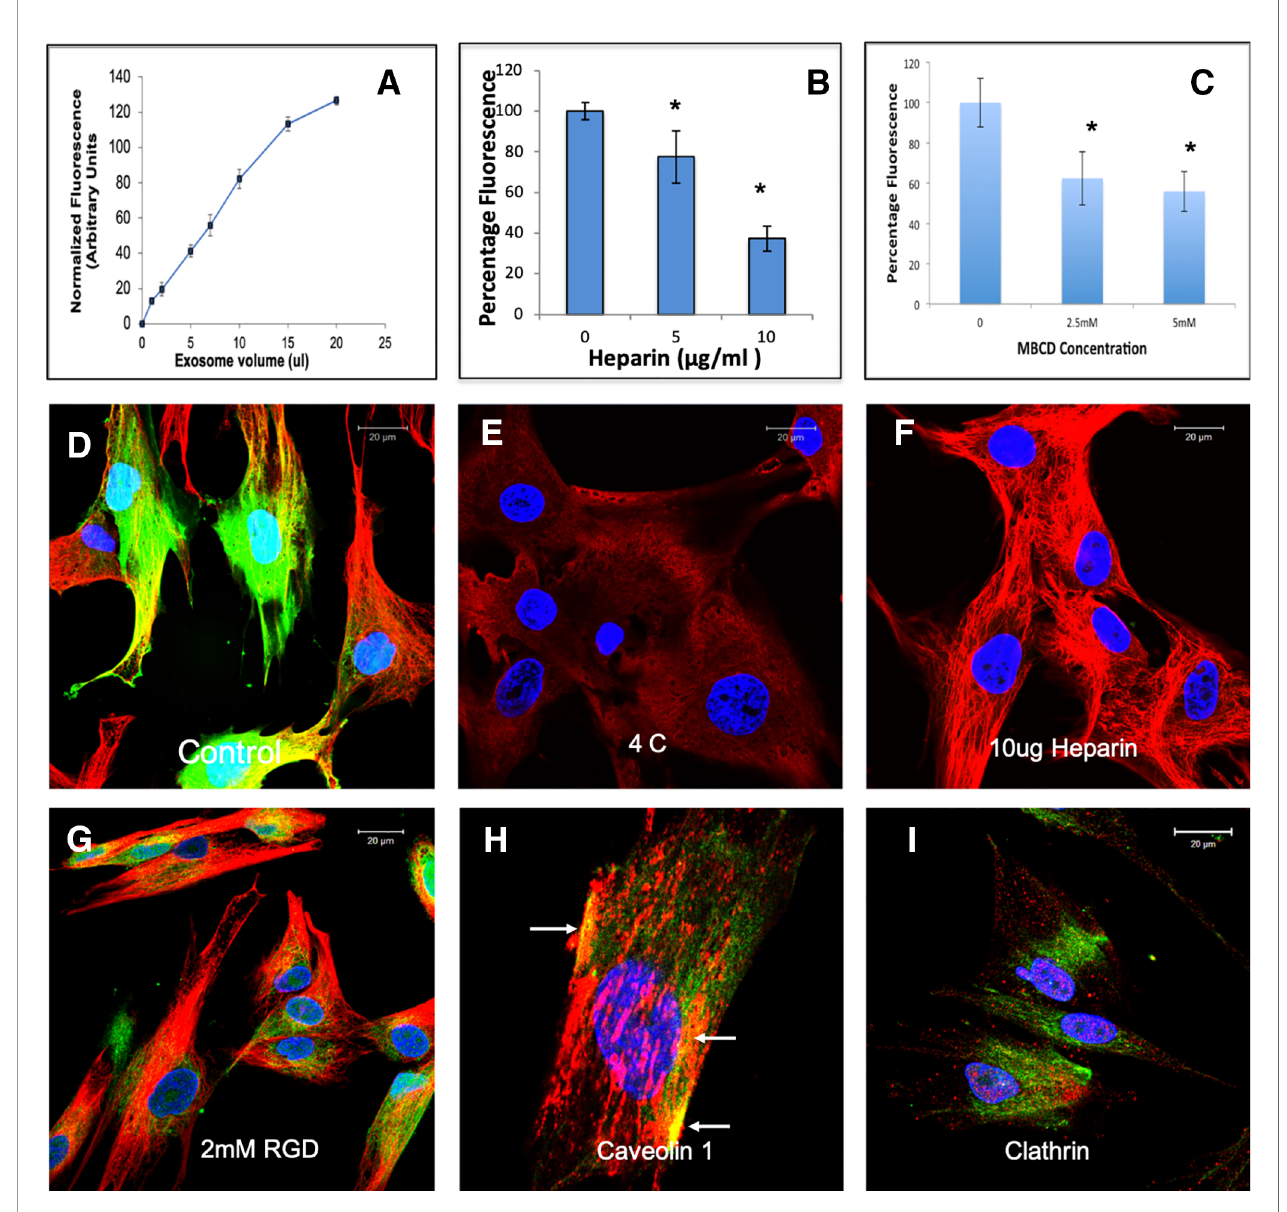
FIGURE 2 | Endocytosis of human mesenchymal stem cell (HMSC) extracellular vesicles (EVs) by HMSCs: (A) Graphical representation of dose-dependent and saturable endocytosis of fl uorescently labeled HMSC EVs by naïve HMSCs. Data points represent mean fl uorescence +/ − SD (n=6). The EV volume/particle number was standardized as described under the methods section. (B) Graph showing the dose dependent inhibition of HMSC EV endocytosis after pre-treatment of the EVs with heparin to block interaction with the cell surface HSPGs. Data represent mean percentage fl uorescence with respect to control +/ − SD. (C) Graph showing the reduction in HMSC endocytosis after disruption of target cell membrane cholesterol with varying doses of methyl- b -cyclodextrin (MBCD). Data is presented as mean percentage fl uorescence with respect to control +/ − SD. Representative confocal micrograph depicting the endocytosed fl uorescently labeled HMSC EVs within target HMSCs after 1 h of incubation at 37°C. (E) Representative confocal micrograph indicating the abrogation of HMSC EV endocytosis when the experiment is performed at 4°C. (F) Representative confocal micrograph showing that pre-treatment of EVs with heparin blocks HMSC EV endocytosis. (G) Representative confocal micrograph of HMSC EV endocytosis after pre-treatment of the cells with 2 mM arginylglycylaspartic acid (RGD) peptide to block cell surface integrins. In images (D – G) , green fl uorescence represents endocytosed EVs. Red fl uorescence represents tubulin counter stain and blue fl uorescence indicates 4 ′ ,6-diamidino-2-phenylindole (DAPI) nuclear stain. (H) Confocal micrograph showing colocalization of endocytosed HMSC EVs (green) with caveolin1 (red). (I) Confocal micrograph showing the absence of co-localization between endocytosed EVs (green) and clathrin (red). * represents statistical signi fi cance (P < 0.05, ANOVA followed by Tukey ’ s ad-hoc ) with respect to